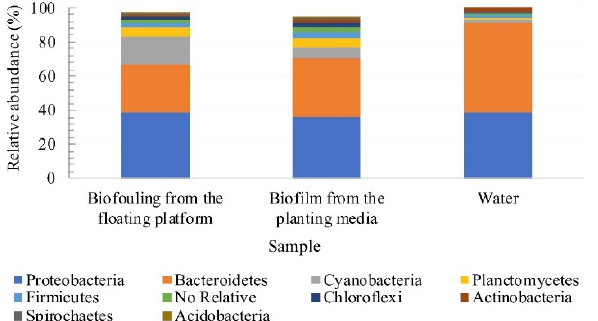
Figure 8. Taxonomic profile of top 10 prokaryotic taxa at higher level (phylum) across all samples. Top 10 represents 91% of the total sequences dataset. Codes: biofouling samples from the floating platform (H = non ‐ planted holes and U = Under surface); biofilm samples from the planting media (SP = Spartina maritima ; SA = Sarcocornia perennis ; and P = Phragmites australis ) and water samples (W); S18 = Summer of 2018; W19 = Winter of 2019 and SP19 = Spring of 2019.